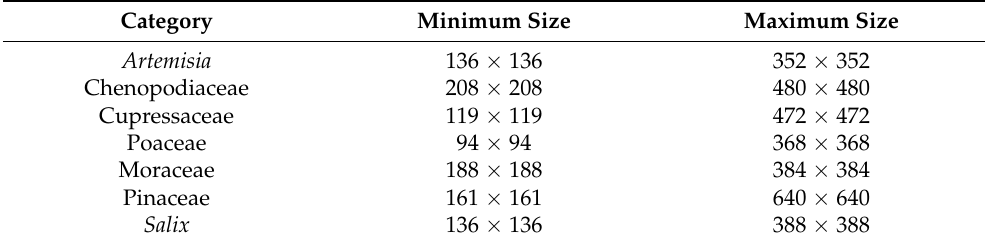
Table 3. The resolution ranges of the categories in the dataset after the deblurring